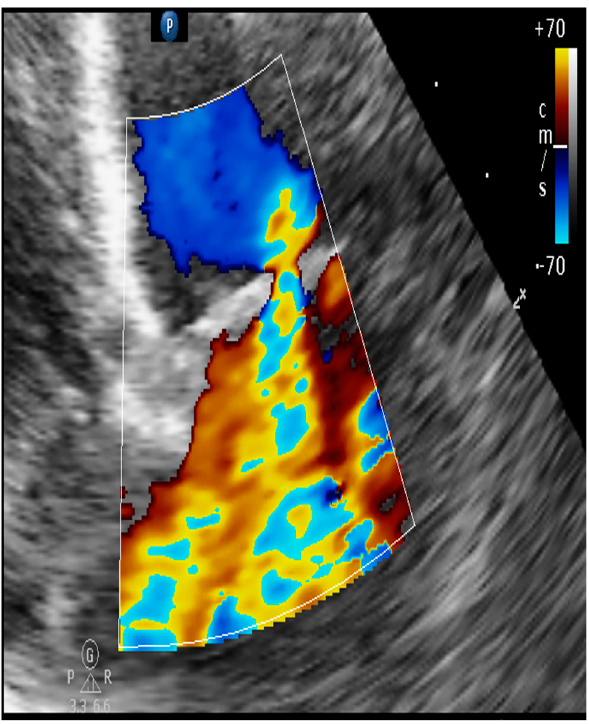
Figure 7. Mitral regurgitation due to myxomatous degeneration with severe regurgitation. The presence of vena contracta that demonstrates greater severity is associated with non-coaptation of the valve leaflets.